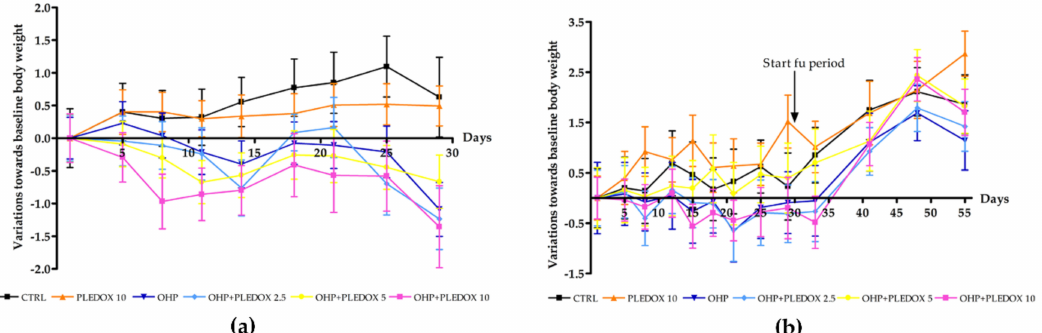
Figure 2. Body weight changes during the study ( a ): mice that performed only 4 weeks of treatment; ( b ): mice that also completed 4 weeks of a follow-up period, mean ± SD).